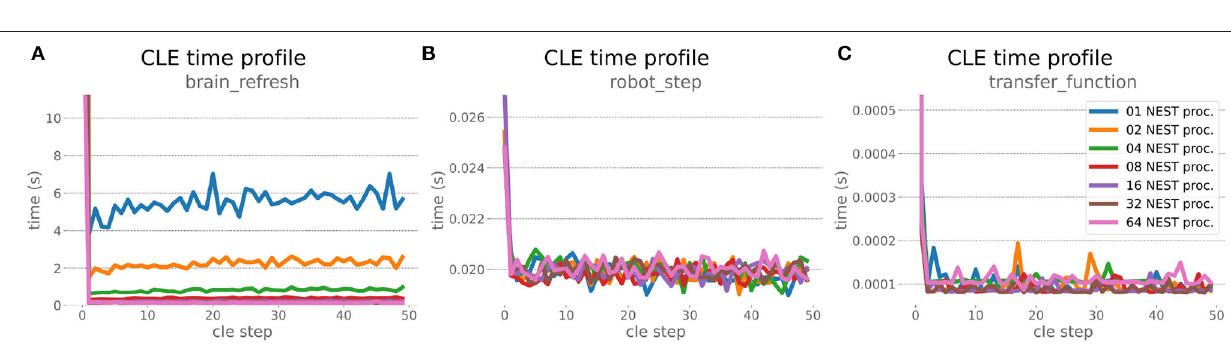
and what the costs related to scaling up execution will